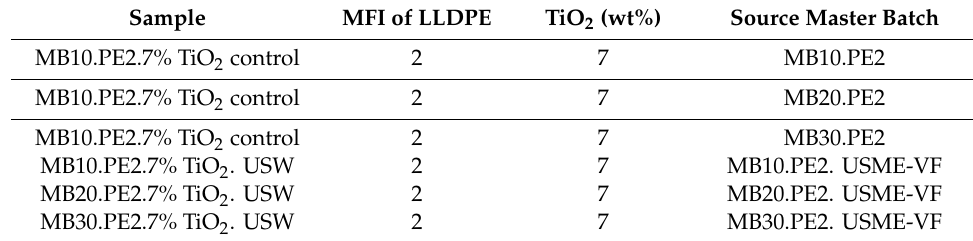
Table 2. Composition and processing conditions of all the